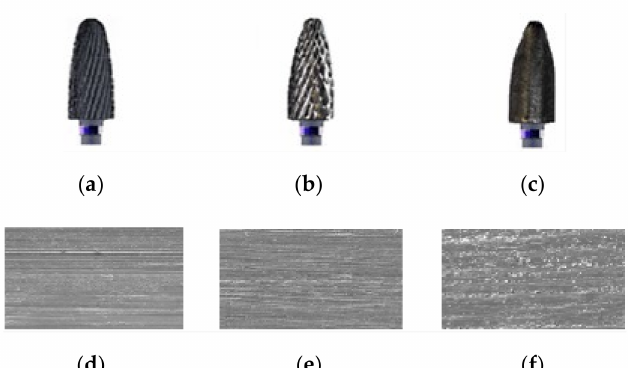
Figure 6. Images of the dental milling cutter wear and of dental material (machined samples): ( a ) standard dental milling cutter after 1 h of operation; ( b ) worn dental milling cutter after 4 h of operation; ( c ) dental milling cutter with the circular crown of the active area, completely worn;